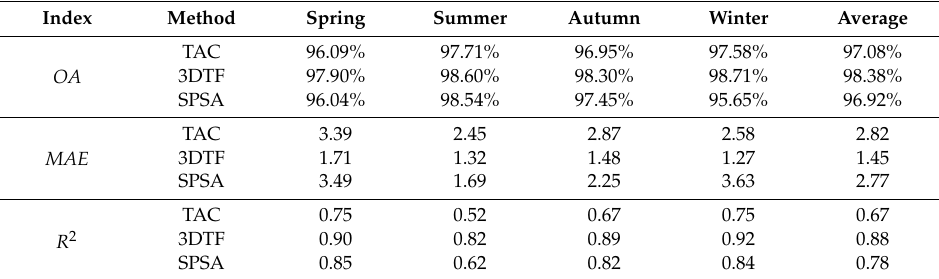
Table 5. Comparisons among the accuracies of the TAC, 3DTF, and SPSA